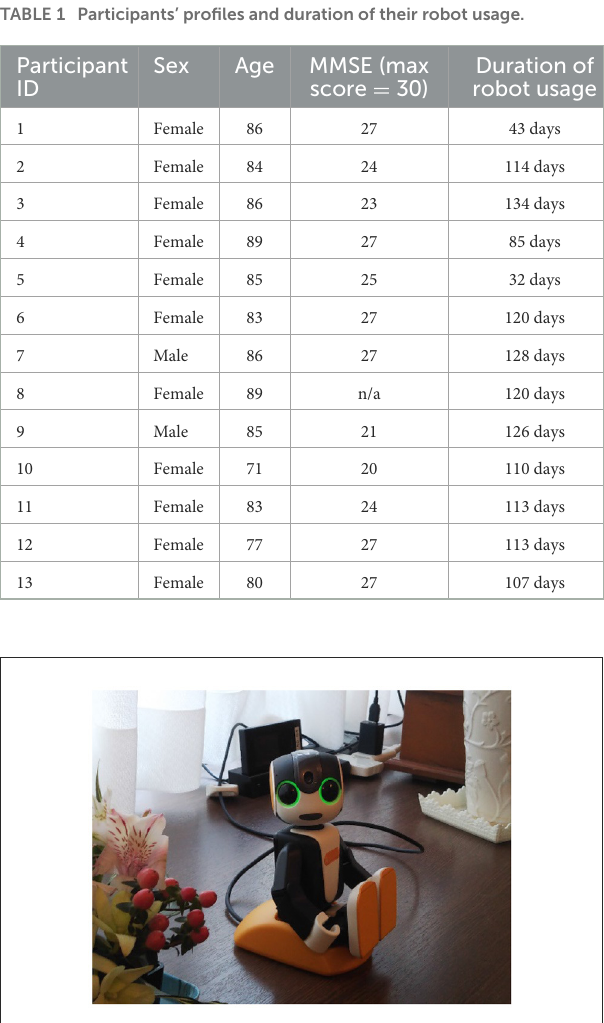
FIGURE1 The RoBoHoN robot.